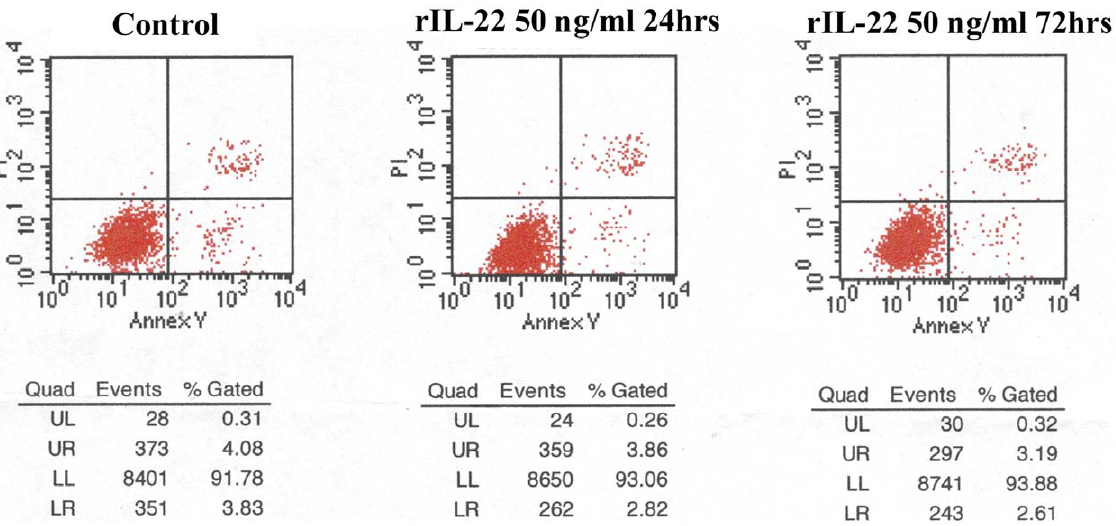
Figure 7. Lack of apoptosis in A498 cells after rhIL-22 treatment. A. Treatment of A498 cells with 50 ng/ml rhIL-22 for 24 h did not induce apoptosis as measured by annexin V or PI-positive cells. B. Treatment of A498 cells with 50 ng/ml rhIL-22 for 72 h did not induce apoptosis.